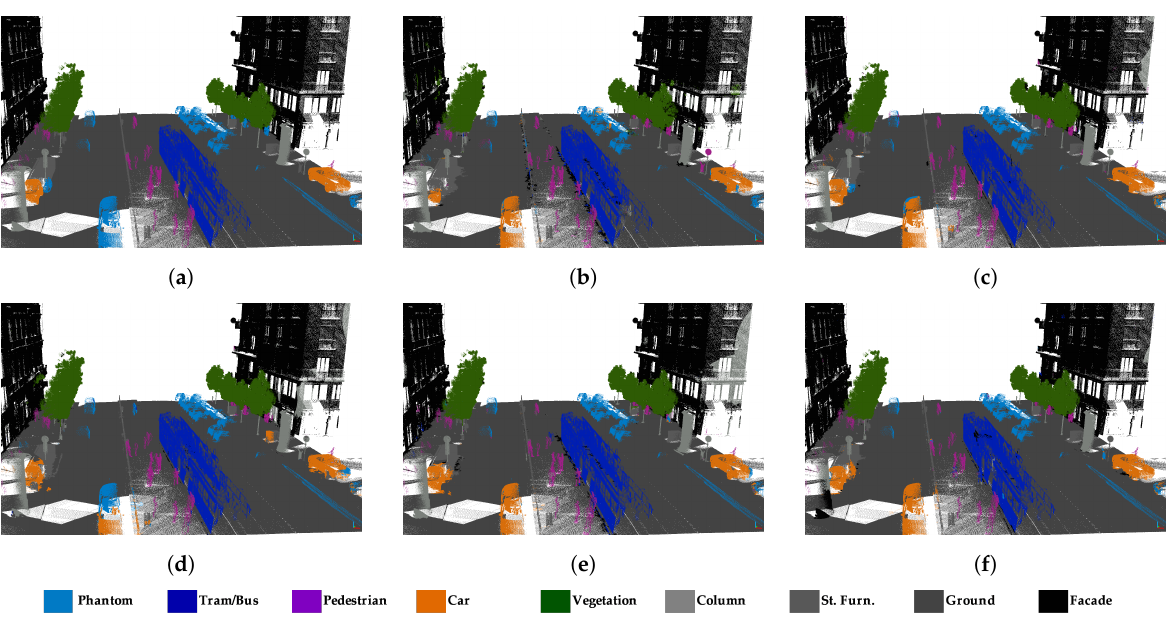
Figure 7. Qualitative results of the methods for SZTAKI-CityMLS with RandLA-Net. ( a )